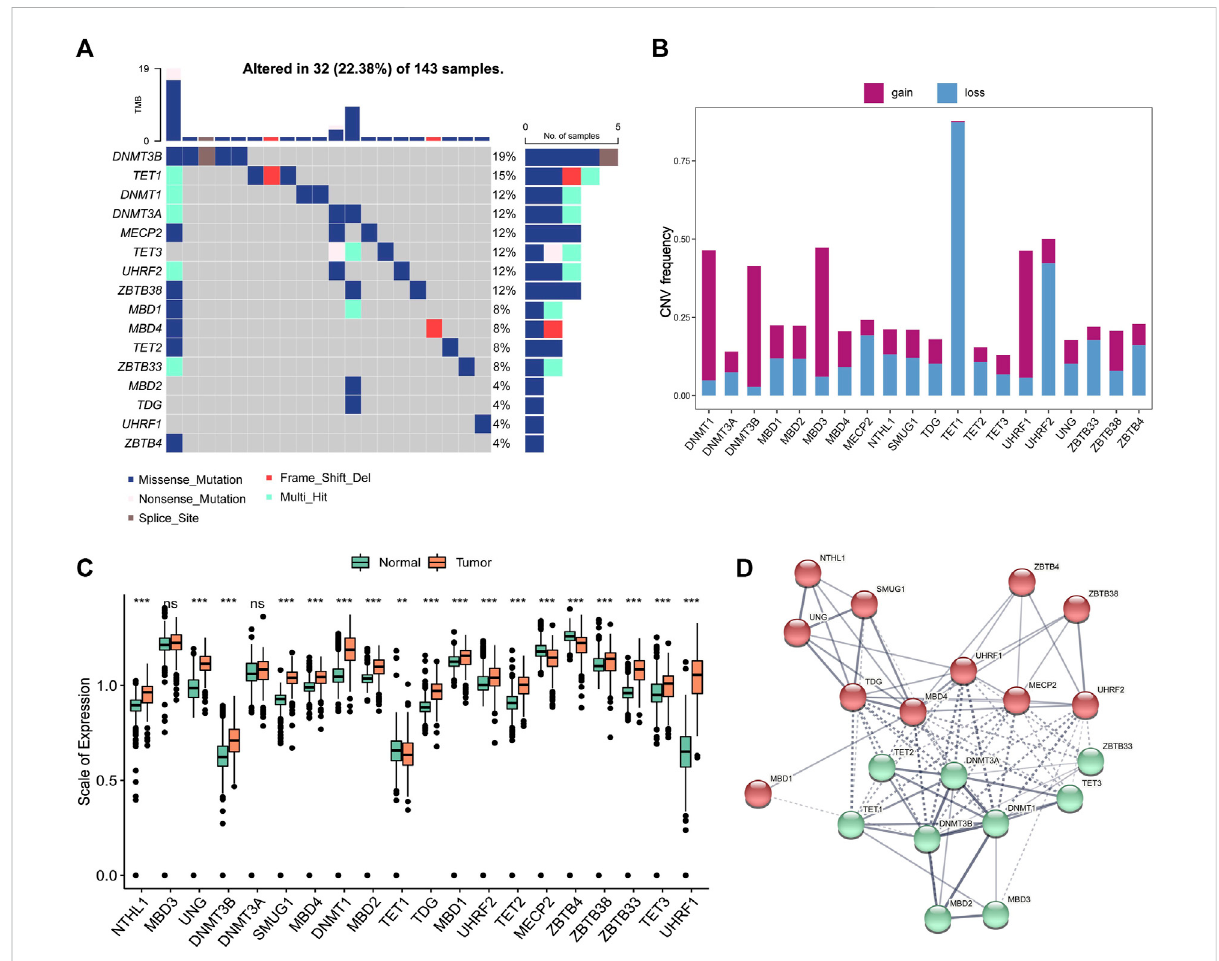
FIGURE 2 Genetic and expression variation of DNA5mC related genes in GBM (A) Mutation frequencies at 20 DNA5mC regulators in the TCGA-GBM cohort. (B) DNA5mC regulator CNV variation frequency. (C) A comparison of the expression of 20 DNA5mC regulators between normal tissues and GBM tissues. (D) Diagram of gene interaction at the protein